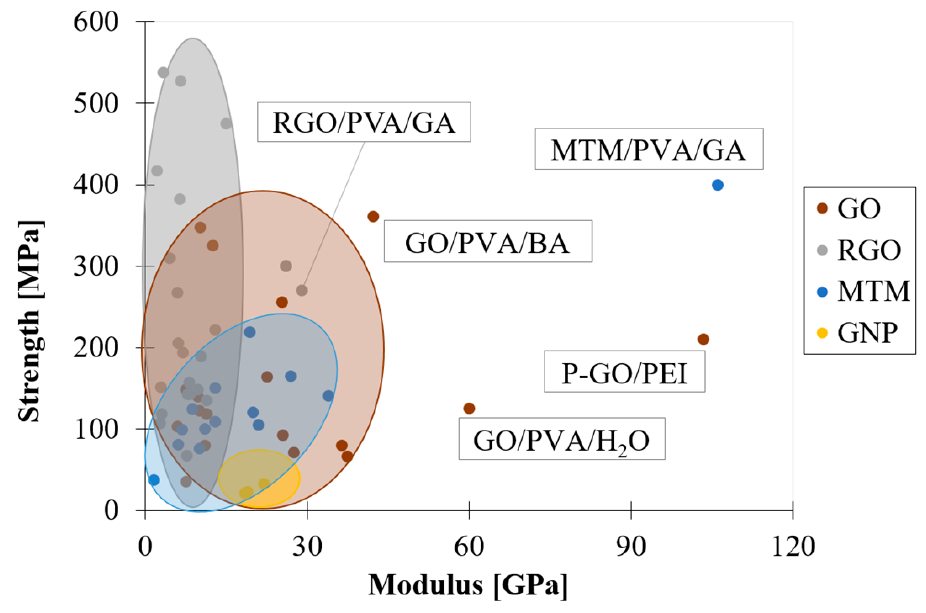
Figure 2. Ashby plot of strength vs. modulus of brick-and-mortar composite with bricks of various nature: GO [34–47]; RGO [14,33,38,41,48–57]; MTM [32,58–63]; GNP [16,64,65].